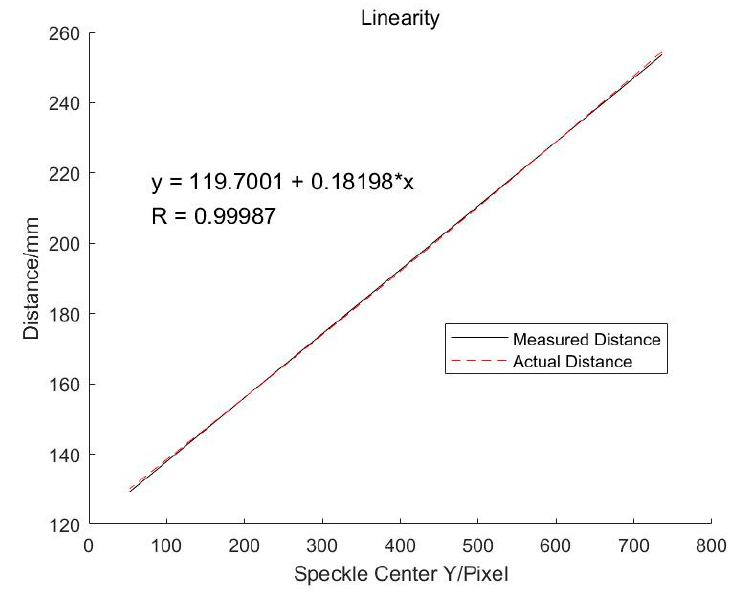
Figure 7. Linearity of the online measurement system.